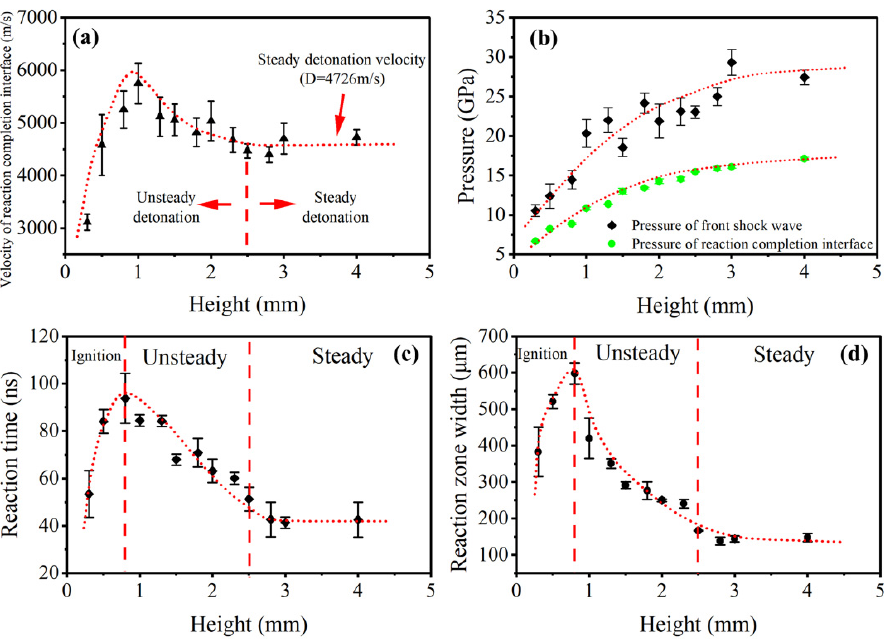
Figure 9. ( a ) Velocity of detonation-reaction–completion interface calculated based on experimental data. ( b ) Pressure of shock front (calculated) and pressure of the reaction–completion interface (experimental data from PVDF gauges) as a function of charge height. ( c ) Detonation-reaction zone duration as a function of charge height. ( d ) Detonation-reaction zone width as a function of charge height.